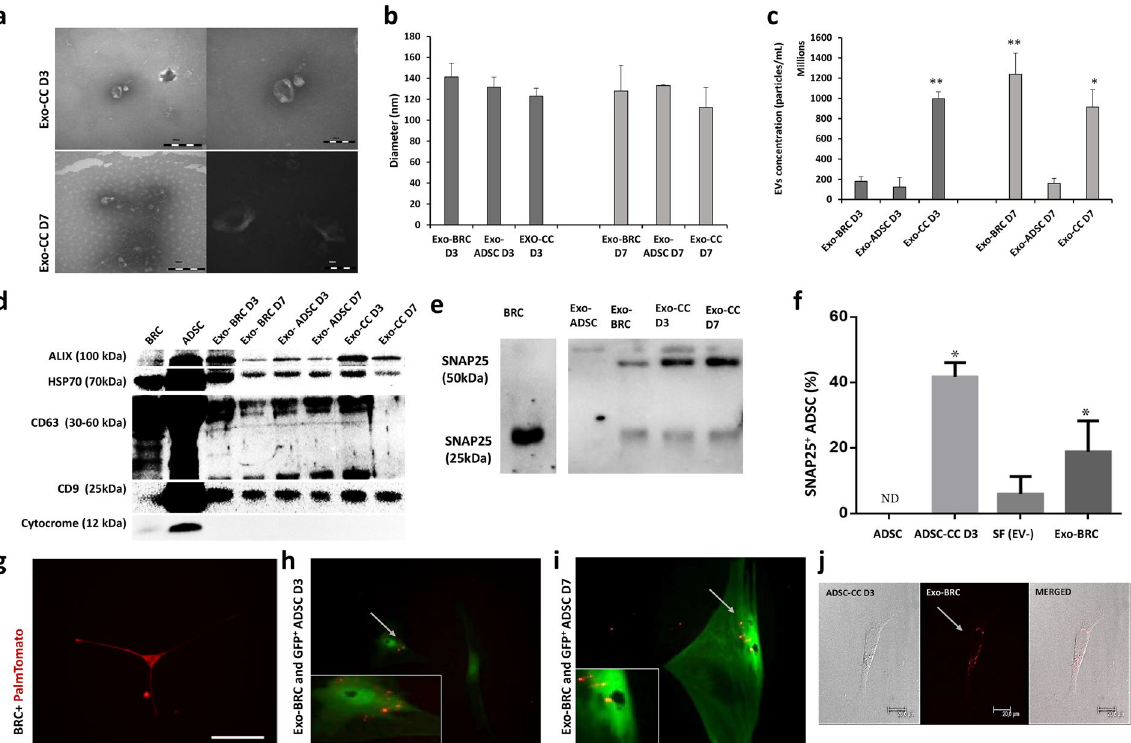
Figure 2. Extracellular vesicles analysis and relationship in ADSC neuronal differentiation - ( a ) Microscopy of transmission of small vesicles from day 3 of co-culture (Exo-CC D3) and day 7 of co-culture (Exo-CC D7). ( b ) Particle diameter (nm) distribution of the isolated particles from control and co-culture (CC) media isolated on day three (D3) and day seven (D7) (Small EVs-Exo) according to nano-tracking analysis. ( c ) Extracellular vesicles concentration according to nano-tracking analysis. ( d ) The western blotting analysis of ALIX, HPS70, CD63, CD9, cytochrome in isolated EVs and control cells (BRC and ADSC). ( e ) The western blotting demonstrating the presence of the SNAP25 protein common in neuronal cells, in small vesicles and abcence in small vesicles from ADSC only. ( f ) Immunocytochemistry quantification demonstrating the presence of the SNAP25 in ADSC (control), ADSC-CC, ADSC cultured with medium without EVs from BRC (Soluble factors-SF), and ASCD cultured Exo-BRC. ( g ) BRC expressing PalmtdTomato reporter (BRC + PalmtdTomato). ( h-i ) Culture of ADSC Exo-BRC + PalmtdTomato after day 3 and 7. ( j ) Co-cultured of ADSC with Exo- BRC + PalmtdTomato after day 3, images demonstrating the presence of EVs + PalmtdTomato together with ADSC. MERGE- merged image showing the extracellular vesicles communication between the cells in the co- culture. Bar = 20 μ m. * p ≤ 0.05 and ** p ≤ 0.001. The bars correspond to the means and the smaller bars are the standard error of the